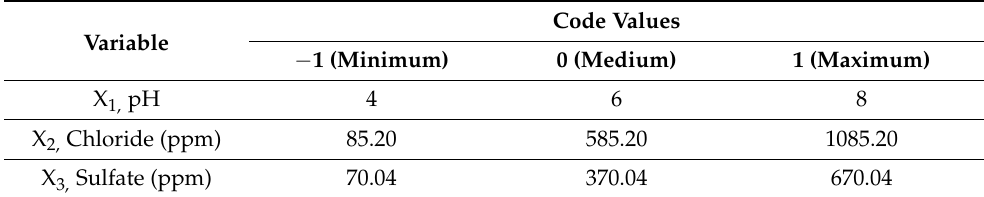
Figure 2. Cube plot design of experiments for corrosion current density according to pH, chloride, and sulfate concentrations by BBD. Table 2. Actual investigated values of factors and their corresponding coded